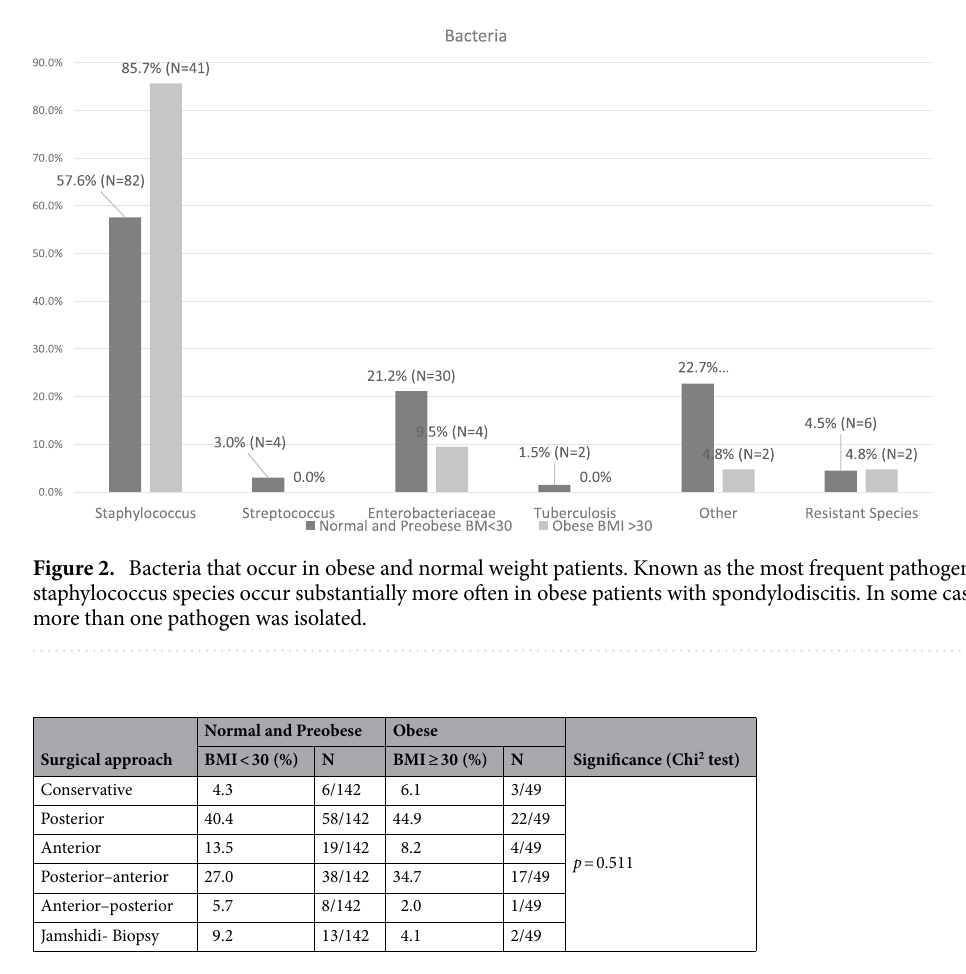
Table 5. Surgical approach. Treatment of patients in the obese group is congruent to treatment of the normal weight group. Even conservative treatment shows equal rates in both rates.